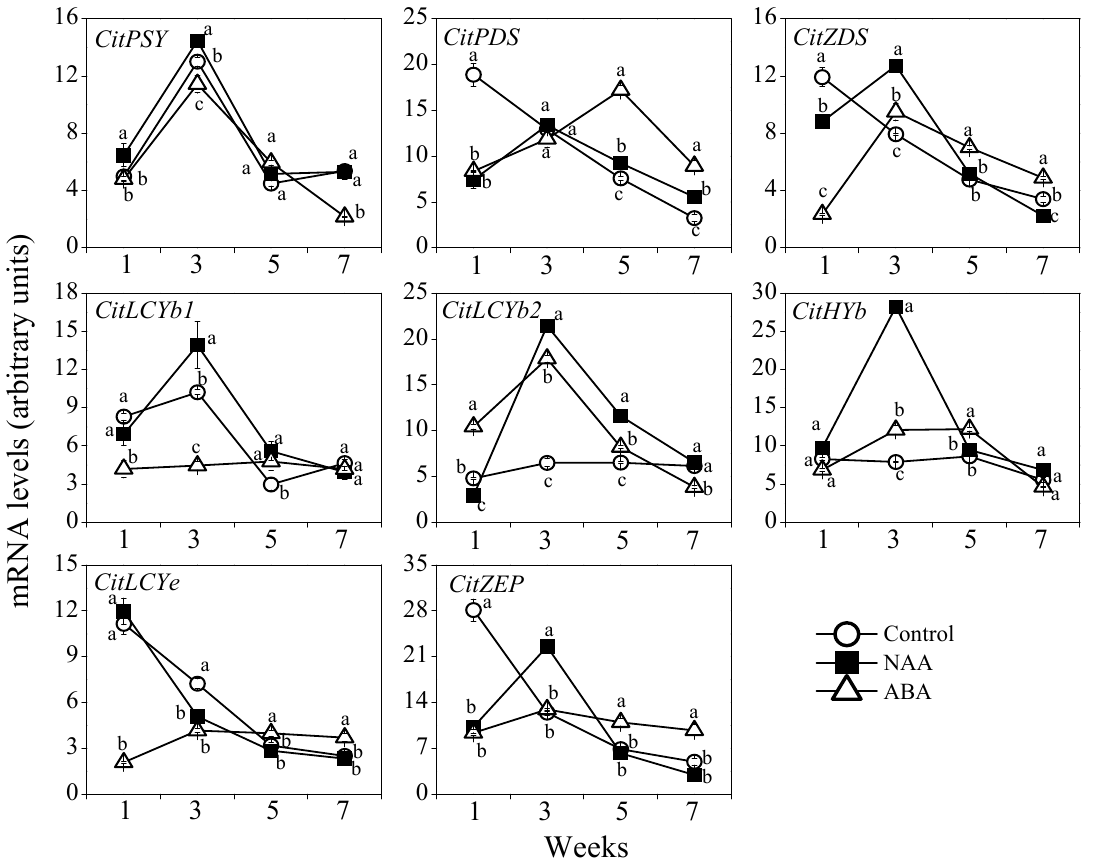
Figure 7. Effect of NAA and ABA on the expression of carotenoid biosynthetic genes in the flavedo of GA and PDJ-treated citrus fruit. The mRNA levels were analyzed by TaqMan quantitative RT-PCR. RT-PCR amplification of 18S ribosomal RNA was used to normalize the expression of the genes under identical conditions. The results shown are the mean ± SE for triplicate samples. Different letters (a, b, and c) indicate significant differences at the 5% level by Tukey’s test.